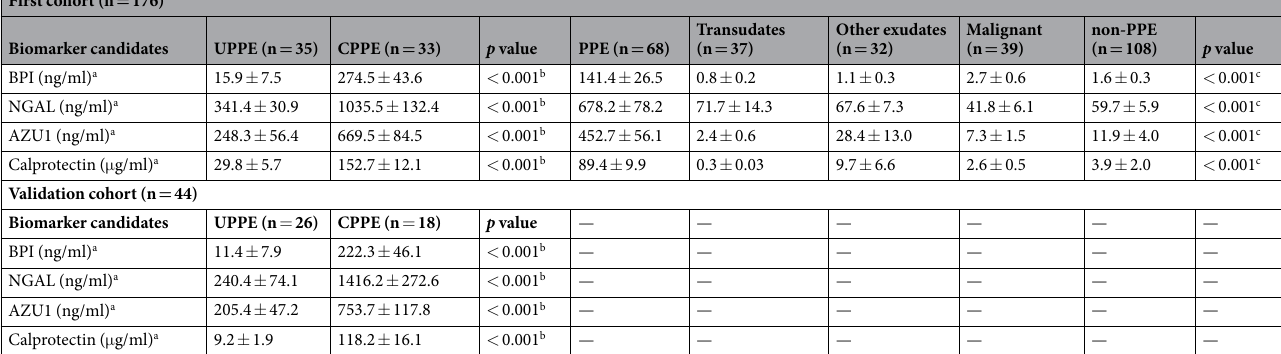
Table 3. Pleural fluid levels of new biomarkers in five types of pleural effusions. a Data are presented as mean ± s.e.m. b The p value of Mann-Whitney U test presents the difference between uncomplicated parapneumonic effusion (UPPE) and complicated parapneumonic effusion (CPPE). c The p value of Mann- Whitney U test presents the difference between parapneumonic effusion (PPE, refer to UPPE and CPPE) and non parapneumonic effusion (non-PPE, refer to transudates, other exudates, and malignant) in this study.